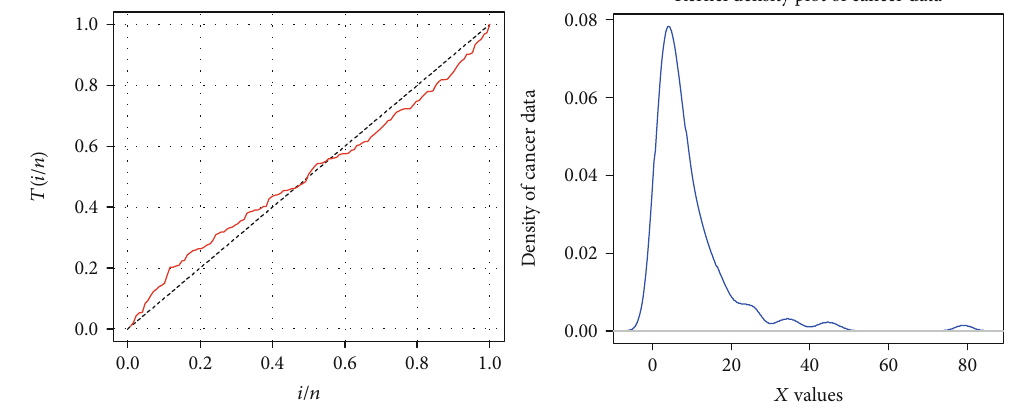
Figure 7: Graph of TTT plot and the kernel density function of the cancer